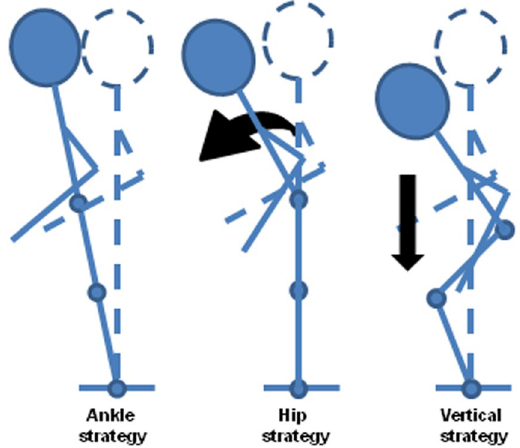
Figure 6. Postural response strategies for maintaining balance following a perturbation (modified after 35 ). In the ankle strategy the toppling moment on the body is countered by a torque around the ankle joint, with the upper body acting as a single inverted pendulum. In the hip strategy a double inverted pendulum is created by an additional torque at the hip. In the vertical strategy all lower limb joints flex to control vertical height to counter the toppling